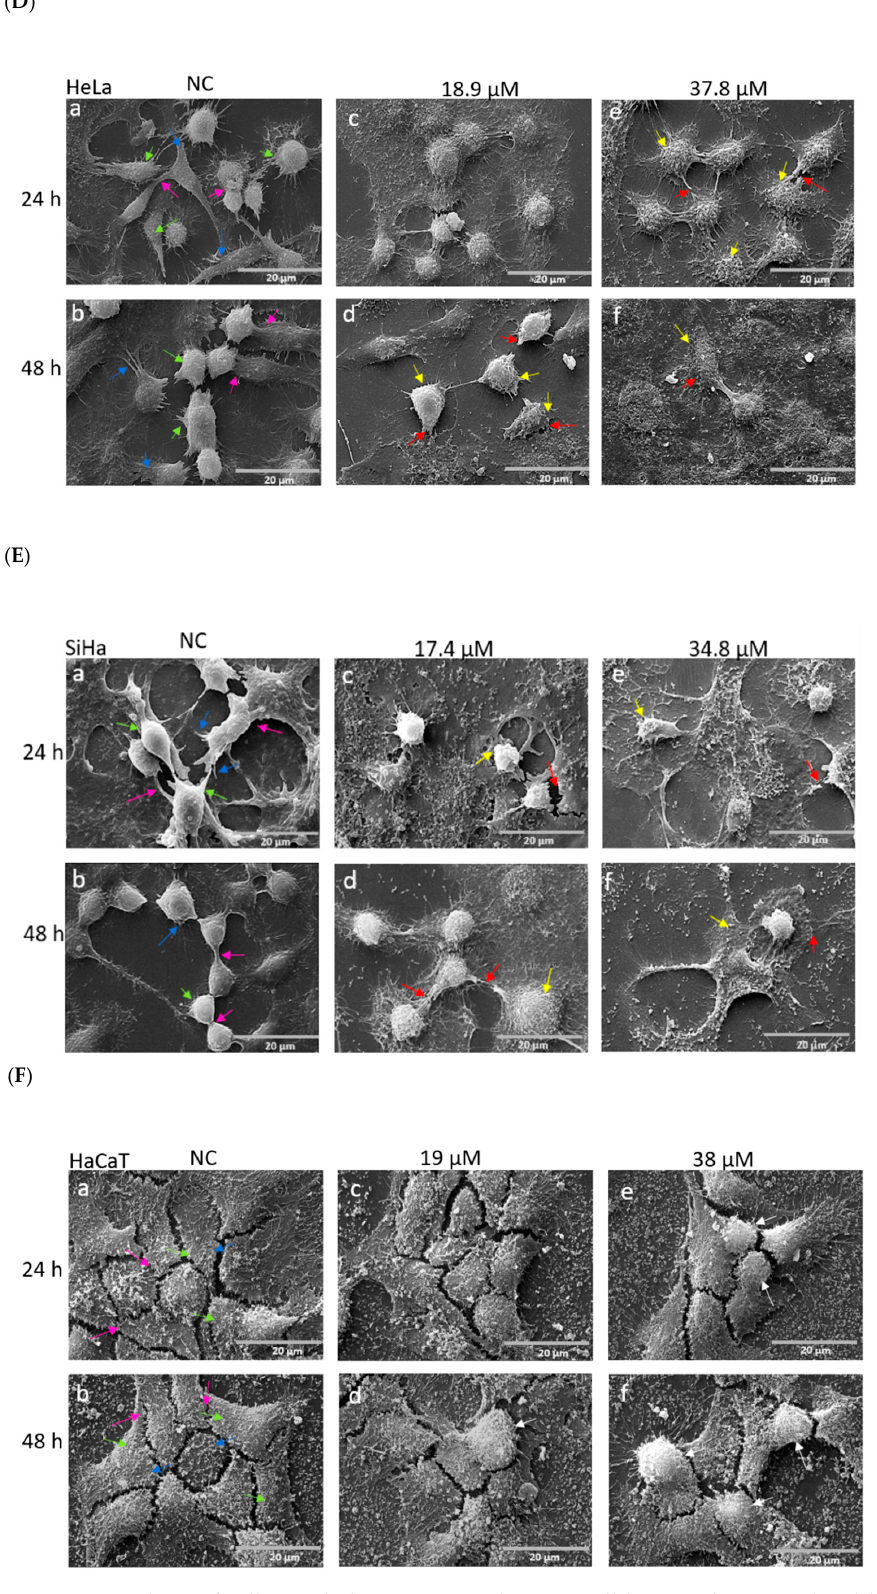
Figure 3. Analysis of cell morphology in cervical cancer cell lines and immortalized human keratino- cytes. ( A ) HeLa and ( B ) SiHa: ( a , b ) NC at 24 and 48 h, respectively. ( c , e ) Cells treated with A3K2A3 (IC 50 or 2xIC 50 ) for 24 h. ( d , f ) Cells treated with A3K2A3 (IC 50 or 2xIC 50 ) for 48 h, ( C ) HaCaT:( a , b ) NC at 24 and 48 h, respectively. ( c , e ) Cells treated with A3K2A3 (19 or 39 µM) for 24 h. ( d , f ) Cells treated with A3K2A3 (19 or 39 µM) for 48 h, images were performed using an Olympus CKX41 inverted phase contrast microscope coupled with an SC30 camera (20x magnification; scale bar: 50 µm). ( D ) HeLa and ( E ) SiHa: ( a , b ) NC at 24 and 48 h, respectively. ( c , e ) Cells treated with A3K2A3 (IC 50 or 2xIC 50 ) for 24 h. ( d , f ) Cells treated with A3K2A3 (IC 50 or 2xIC 50 ) for 48 h, ( F ) HaCaT:( a , b ) NC at 24 and 48 h, respectively. ( c , e ) Cells treated with A3K2A3 (19 or 39 µM) for 24 h. ( d , f ) Cells treated with A3K2A3 (19 or 39 µM) for 48 h. Images were performed in SEM Quanta 250 (FEI) Magnification: 5000x 6500x. 3.3. A3K2A3 Reduce Cell Volume in Cervical Cancer Cells Following the morphological changes visualized by microscopy in both types of treated cancer cells, the determination of cell volume was performed by flow cytometry (Figure 4A,B). HeLa and SiHa cells treated with the IC 50 showed a reduction in cell volume of 22 and 21%, respectively. Treatments with 2xIC 50 concentrations ledl to even greater cell volume reductions (28 and 37.5% for HeLa and SiHa, respectively) compared to the NC. CPT was used as a PC and induced a notable decrease in the cell volume for both cell types (26 and 22% for HeLa and SiHa cells, respectively). The treatments for 24 h did not show significant differences in relation to the NC.